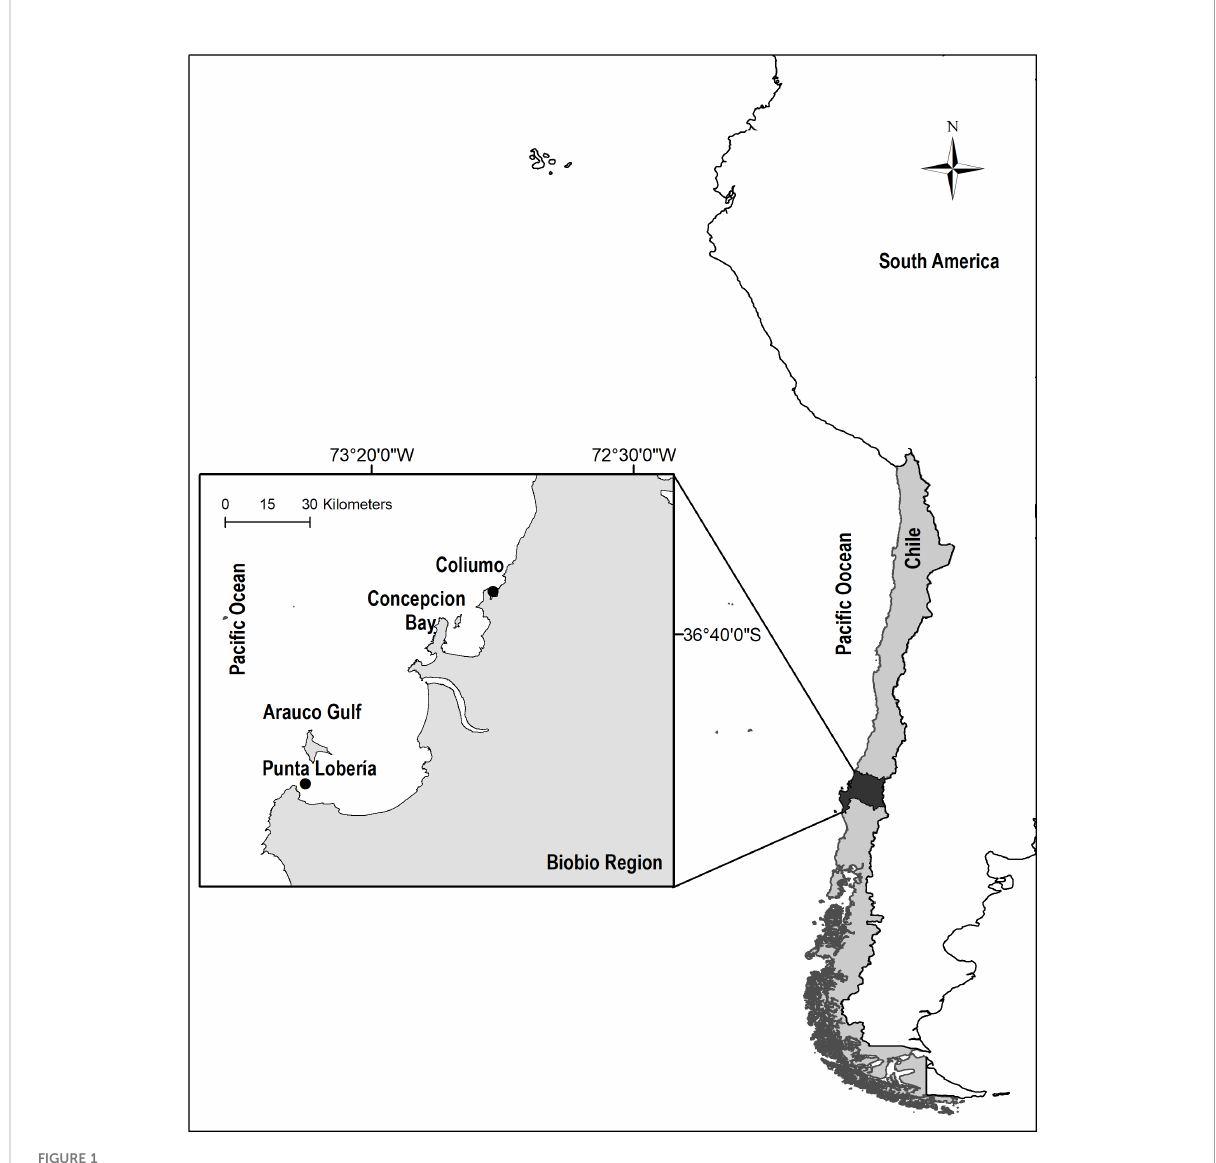
FIGURE 1 Study coastal zones in Biob ı ́ o region,